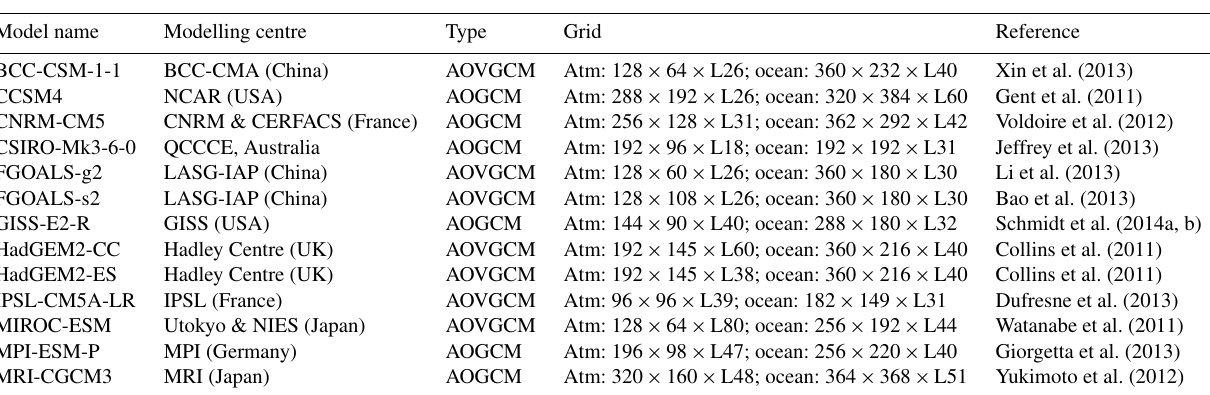
Table 3. PMIP3 model characteristics and